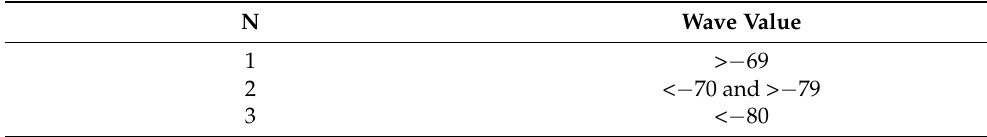
Table 2. The setting value of N for various wave value.